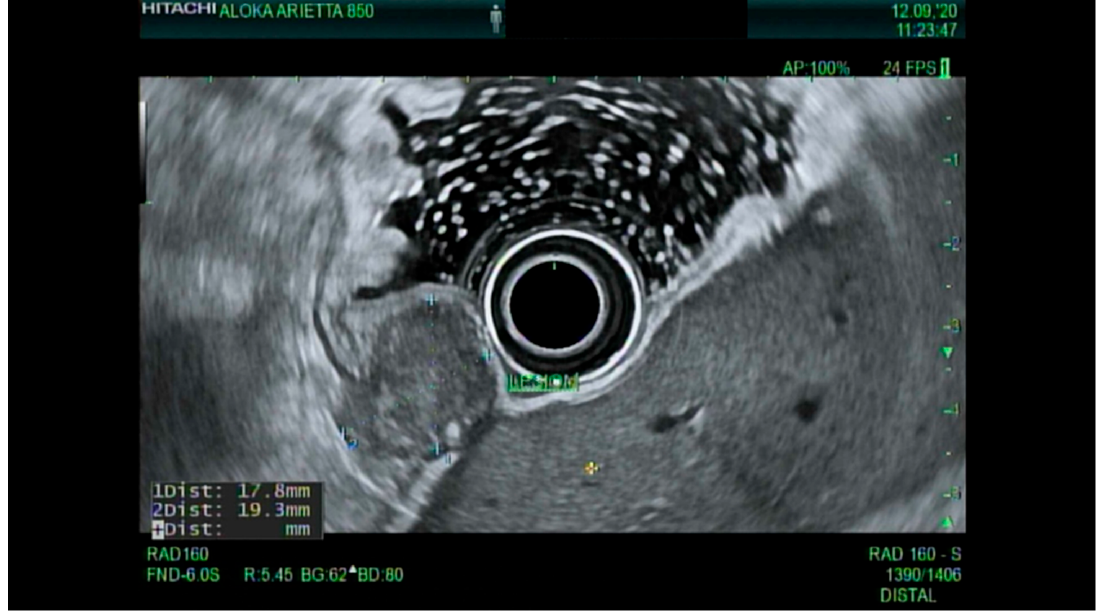
Figure 13. EUS images of a gastrointestinal stromal tumor originating from muscularis propria.